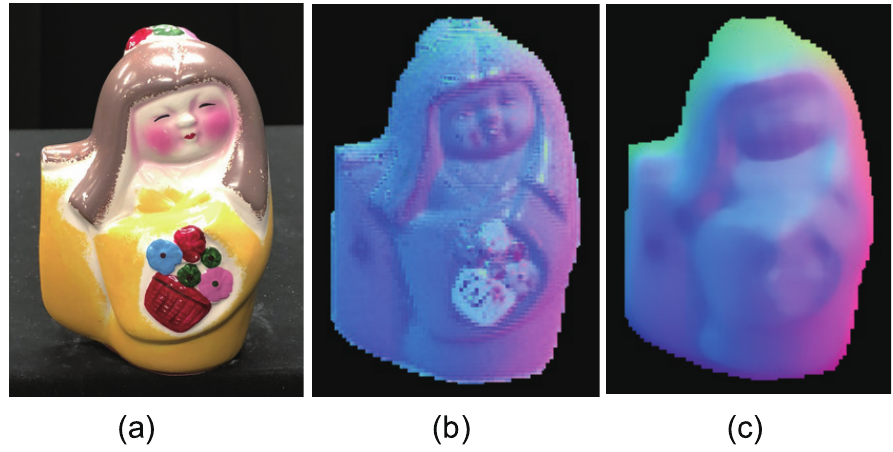
Figure 19. The results for doll object, which causes strong specular reflection. Estimated surface normal [doll]: ( a ) Target object, ( b ) surface normal of naive color photometric stereo, and ( c ) surface normal of our method. The proposed method is not affected by the albedo difference appears at the flower